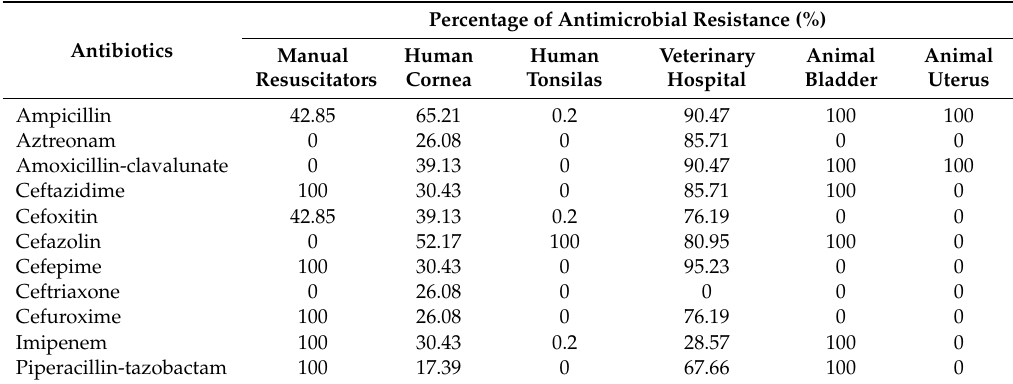
Table 1. Percentage of antimicrobial resistance by sample source (%).